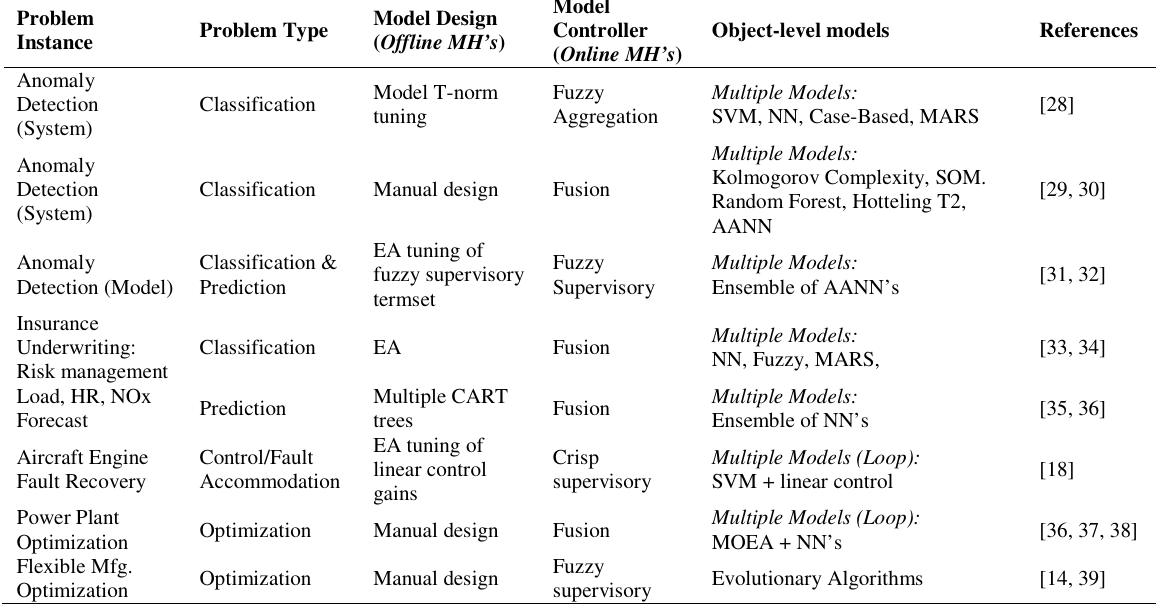
Table 2. SC Techniques & Domain